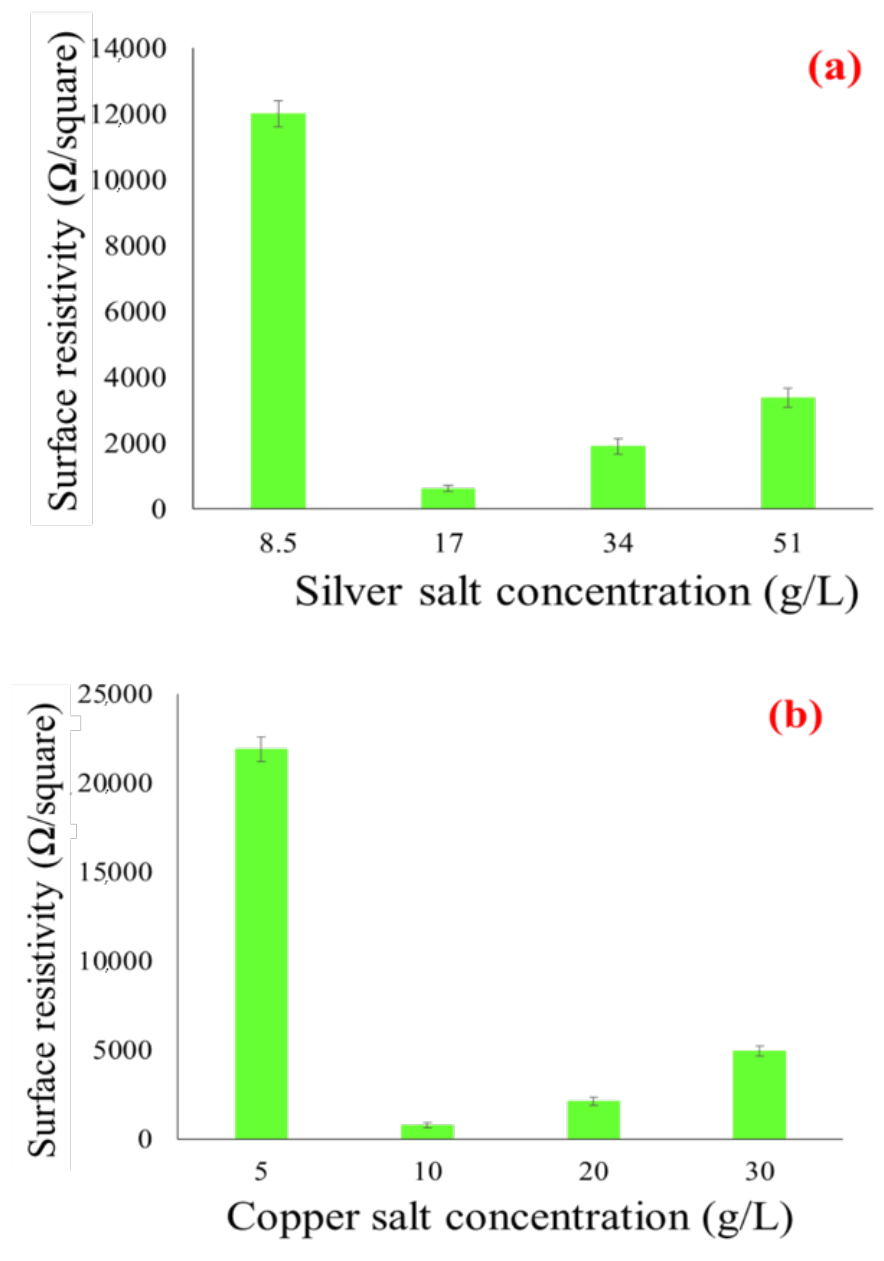
Figure 5. Surface resistivity of silver coated fabrics for different ( a ) silver nitrate concentrations and copper coated fabrics for different ( b ) copper sulfate concentrations.